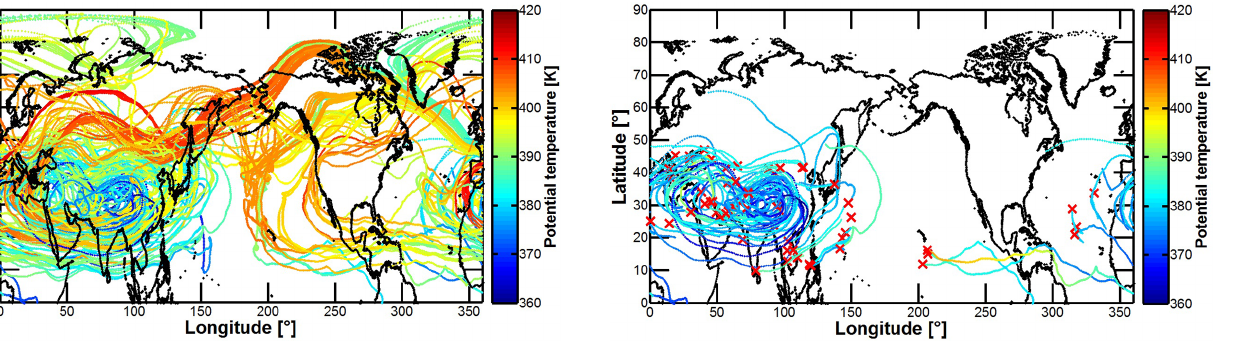
Figure 6. Fifty-day backward trajectories for flight sections where (cid:50) > 370 K, PV > 7.5pvu. To select trajectories which experienced a diabatic ascent to the flight level, we only show trajectories with a minimum potential temperature which is at least 5K below (cid:50) at the measurement location (cf. Fig. 5). Colour: potential temperature along the backward trajectories based on ERA-Interim reanalysis data.